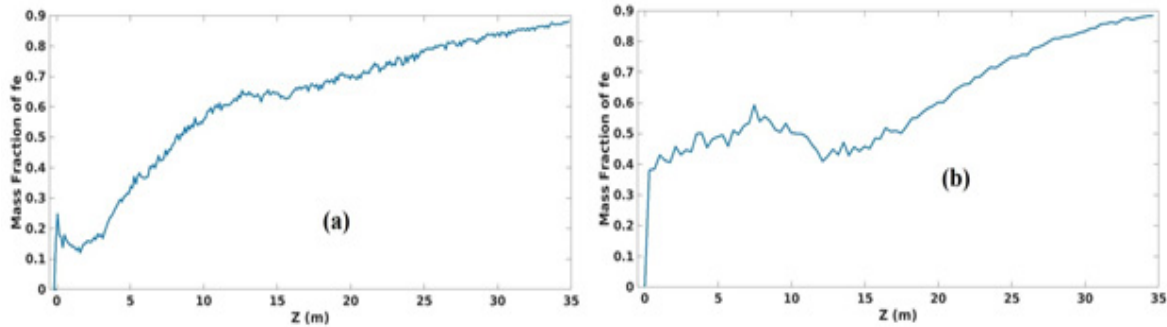
Metals 2021 , 11 , 332